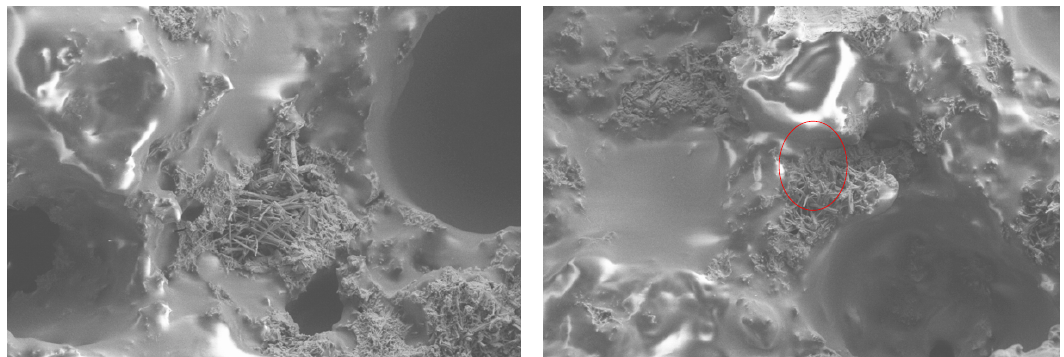
Figure 1. Microstructure of cement-emulsified asphalt mortar.